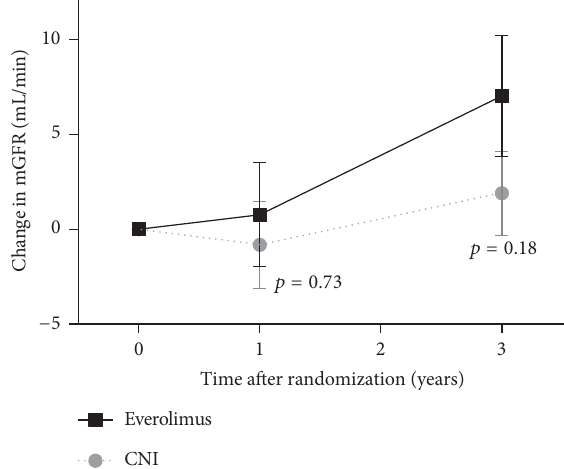
Figure 3: Mean (SEM) change in measured GFR from baseline. CNI, calcineurin inhibitor; SEM, standard error of the